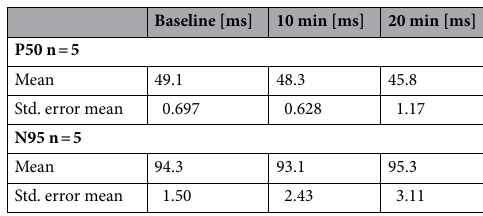
Table 2. Implicit times of PERG in